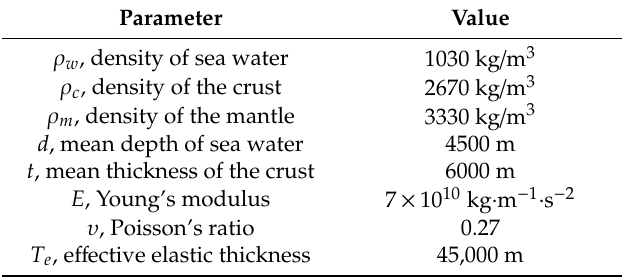
Table 1. Parameters used to calculate the admittances in Figures 1 and 2.